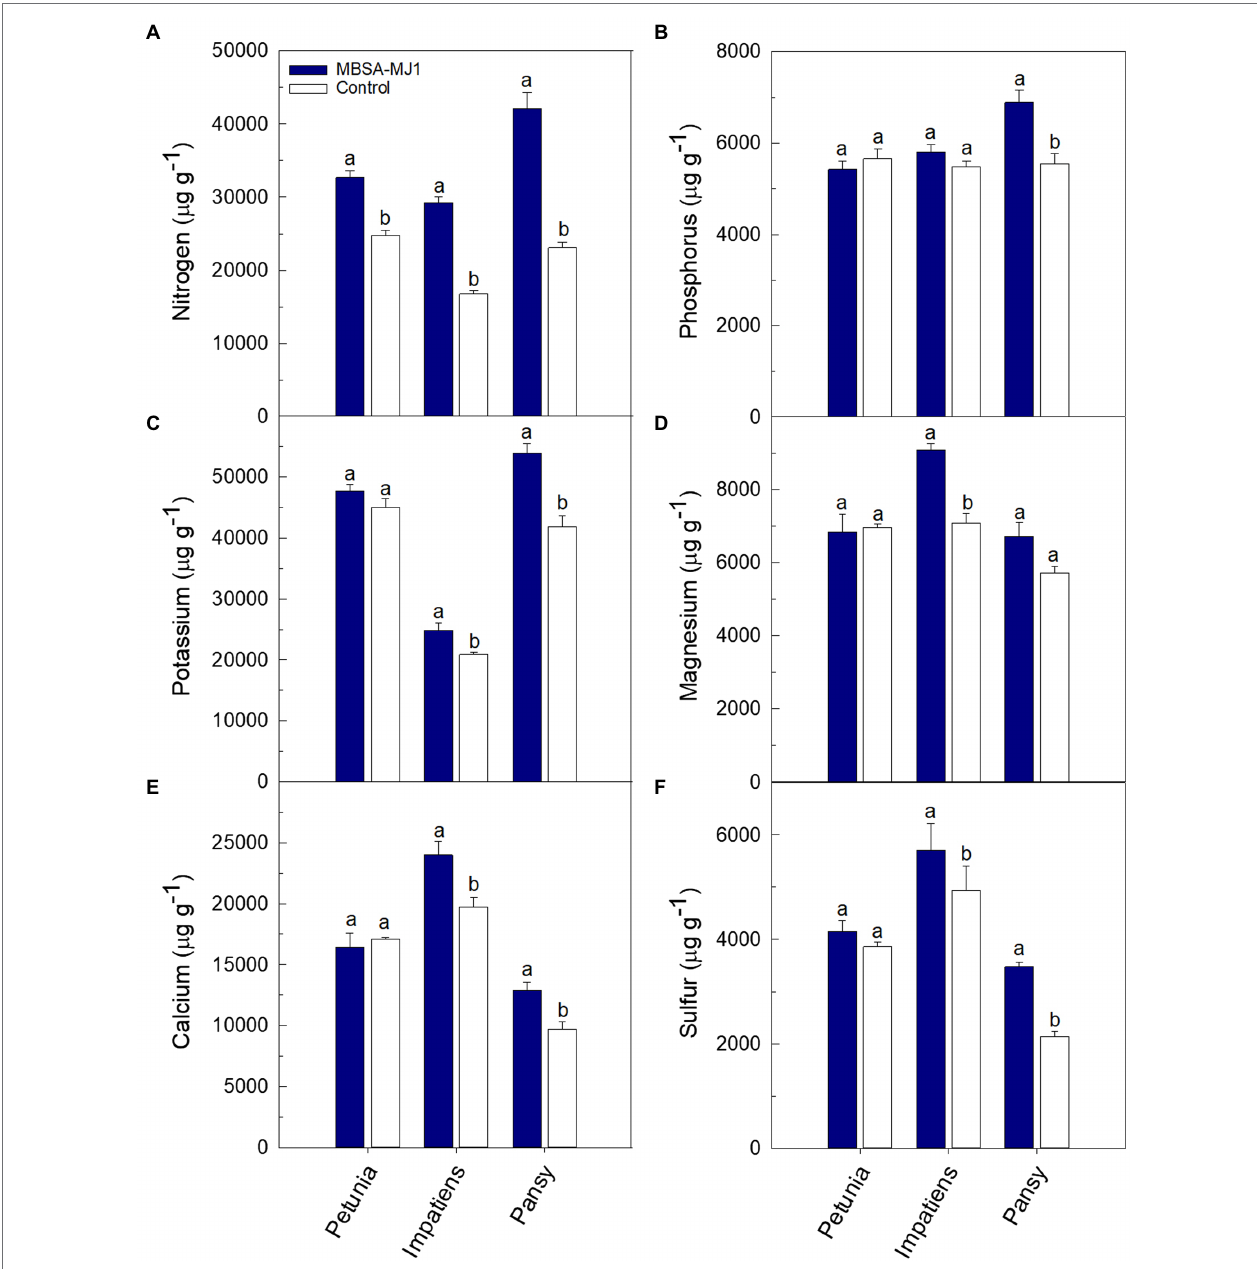
FIGURE 3 | Tissue macronutrient concentration of Petunia × hybrida (petunia), Impatiens walleriana (impatiens), and Viola × wittrockiana (pansy) plants grown under low-nutrient conditions: nitrogen (A) , phosphorus (B) , potassium (C) , magnesium (D) , calcium (E) , and sulfur (F) . Plants were treated weekly with a media drench of S. plymuthica MBSA-MJ1 (blue bars) or uninoculated LB (control; white bars). Tissue nutrient concentration was evaluated 8 weeks post-transplant. Bars represent the mean (±SE) with different letters representing significant differences ( p < 0.05) and n =